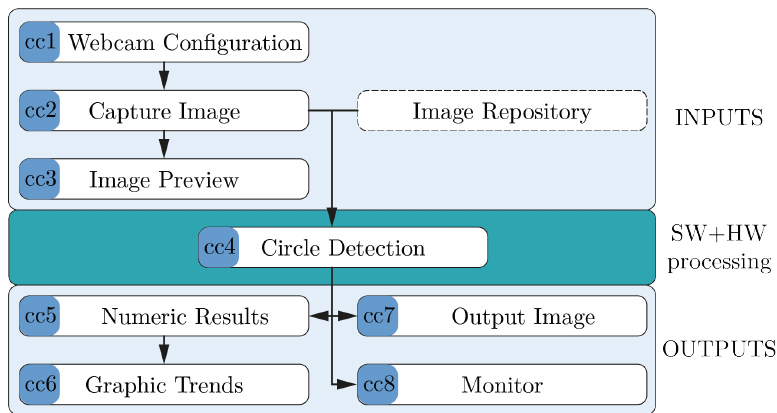
Figure 10. Flowchart of the Circle Detection System tasks coded in a